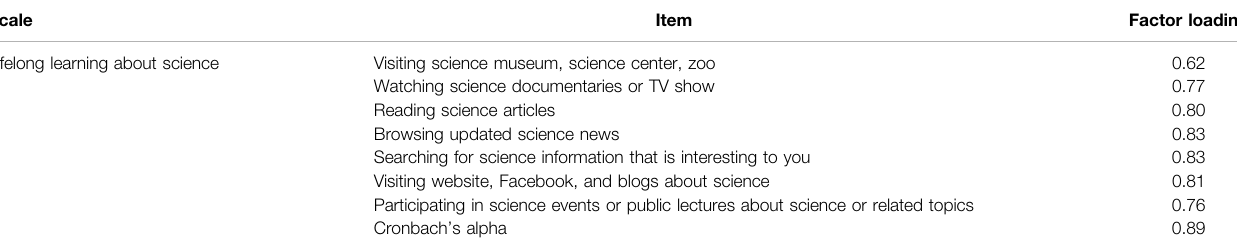
TABLE 3 | Summary of rotated factor analysis loading results > 0.35 for 7 items on Lifelong learning about science in the post-presenting survey.